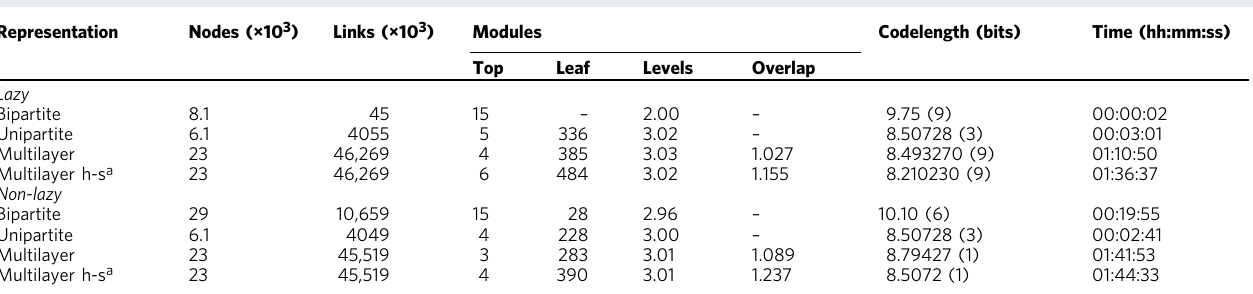
Table 4 Optimised fl ow-based multilevel communities of the hypergraph of metabolic reactions in C. elegans represented with different networks.